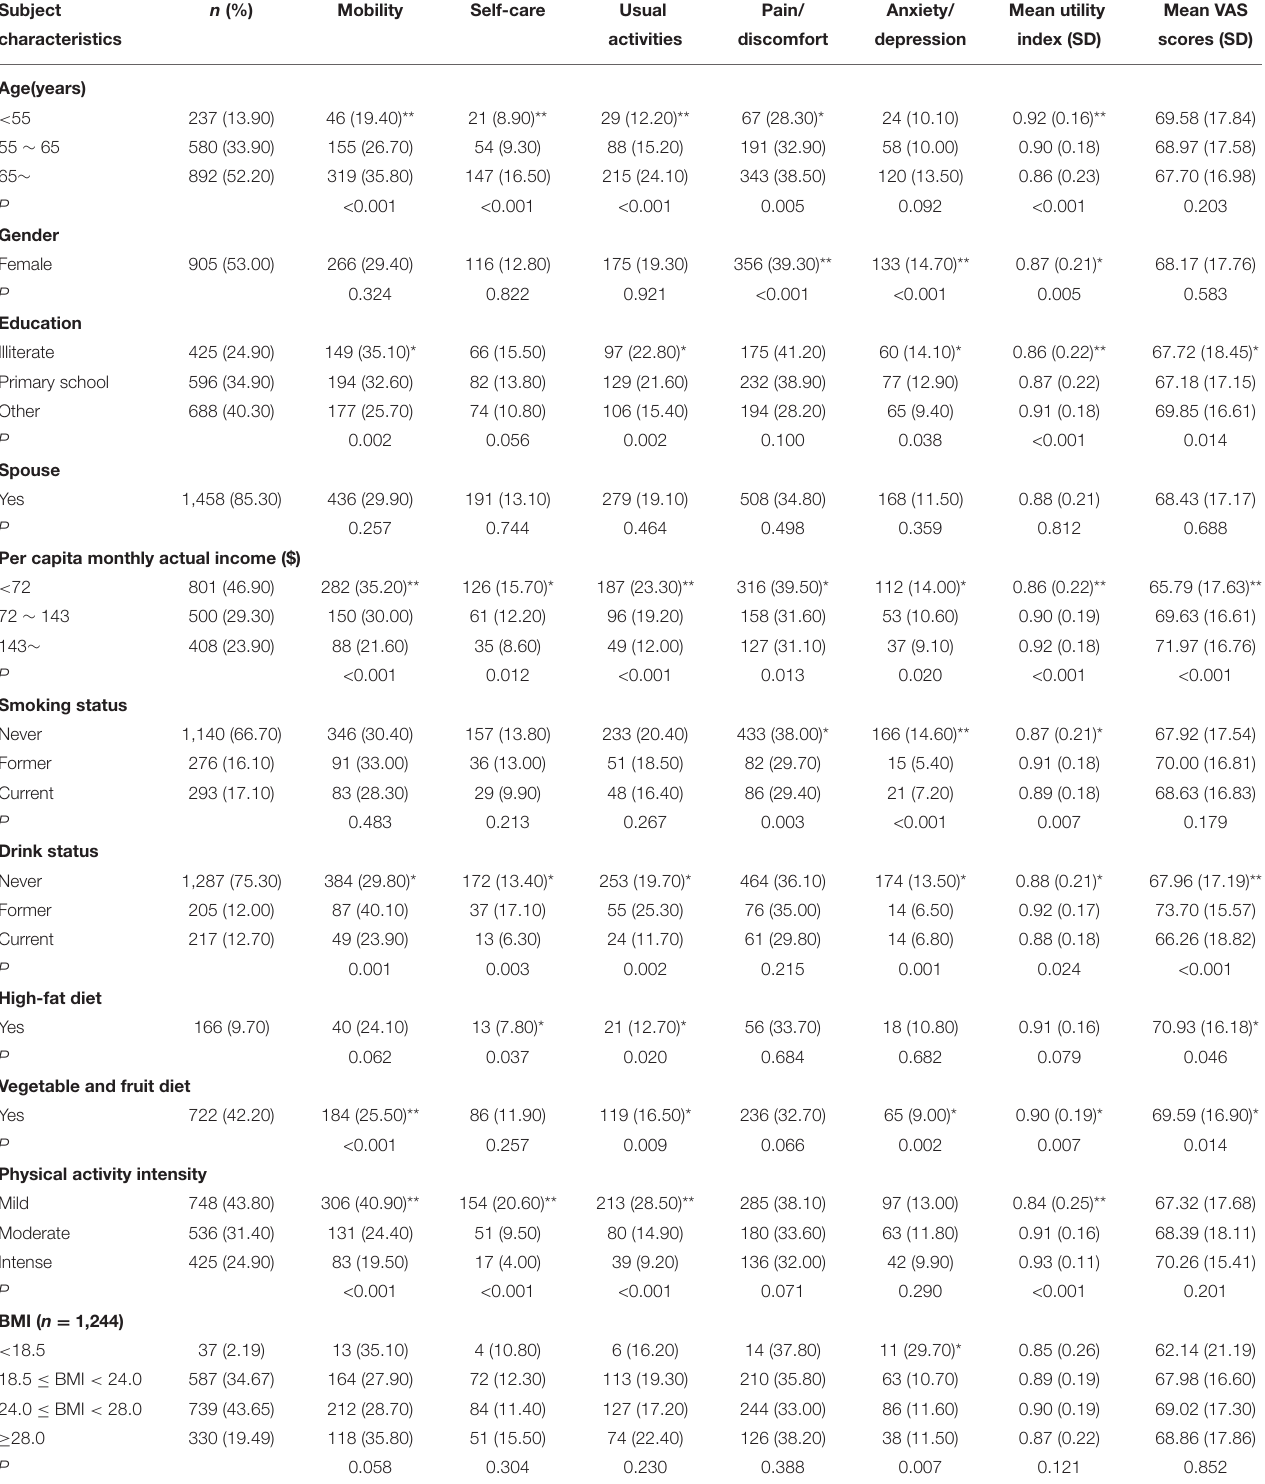
TABLE 2 | Distribution of stroke patients within different subgroups over reporting problems (slight to extreme problems) of the EQ-5D dimension, mean (SD) EQ − 5D utility index, and VAS score ( n =